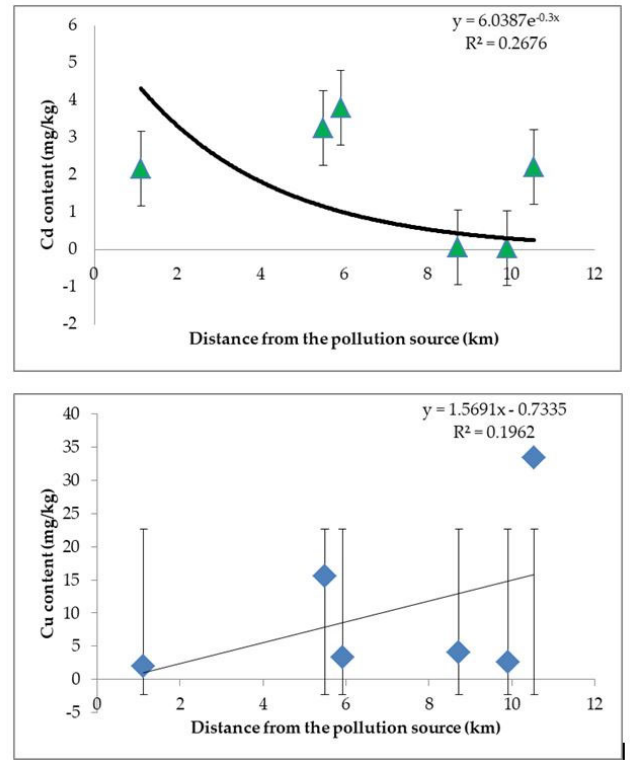
Figure 2. Cd (up) and Cu (down) content in honey against the distance from the main source of